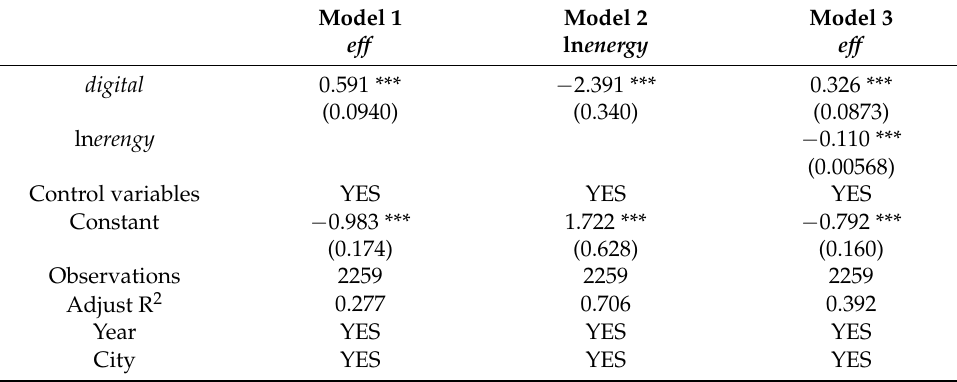
Table 7. Intermediary effect regression